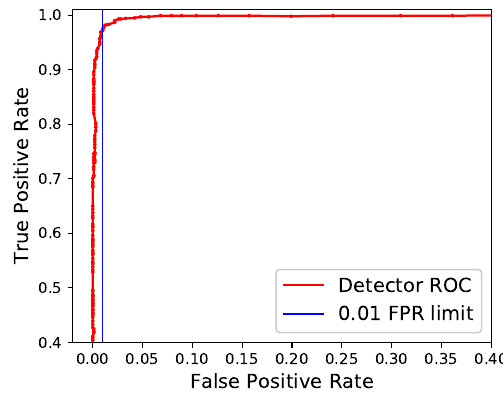
Figure 9. Receiver operating characteristic curve showing the performance of the New Forest cicada detector at various thresholds. The final threshold was chosen by capping the false-positive rate to 0.01 and taking the threshold which corresponded with the highest attainable true-positive